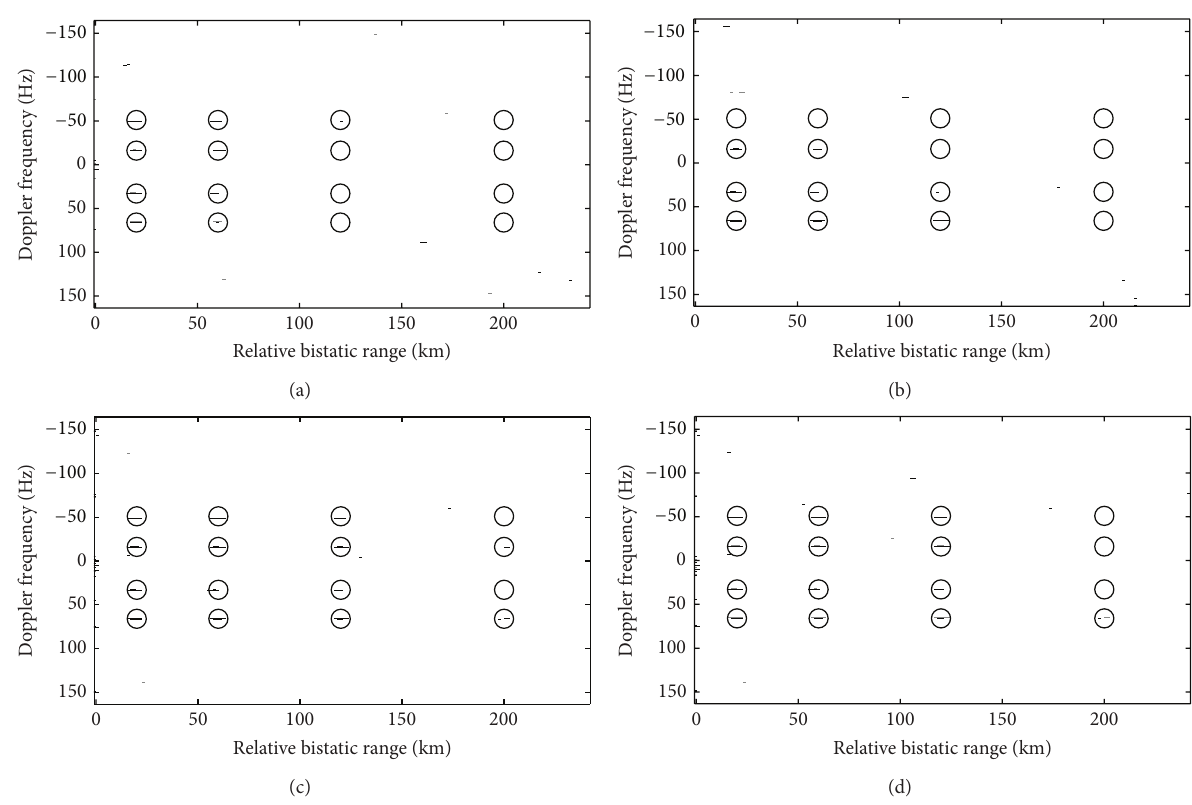
Figure 11: Detection results in the presence of a single stationary obstacle (DoA close to targets’ DoAs) for (a) side lobe control by central element tapering (nonadaptive), (b) optimum filter, (c) principal eigenvalue approach, and (d)